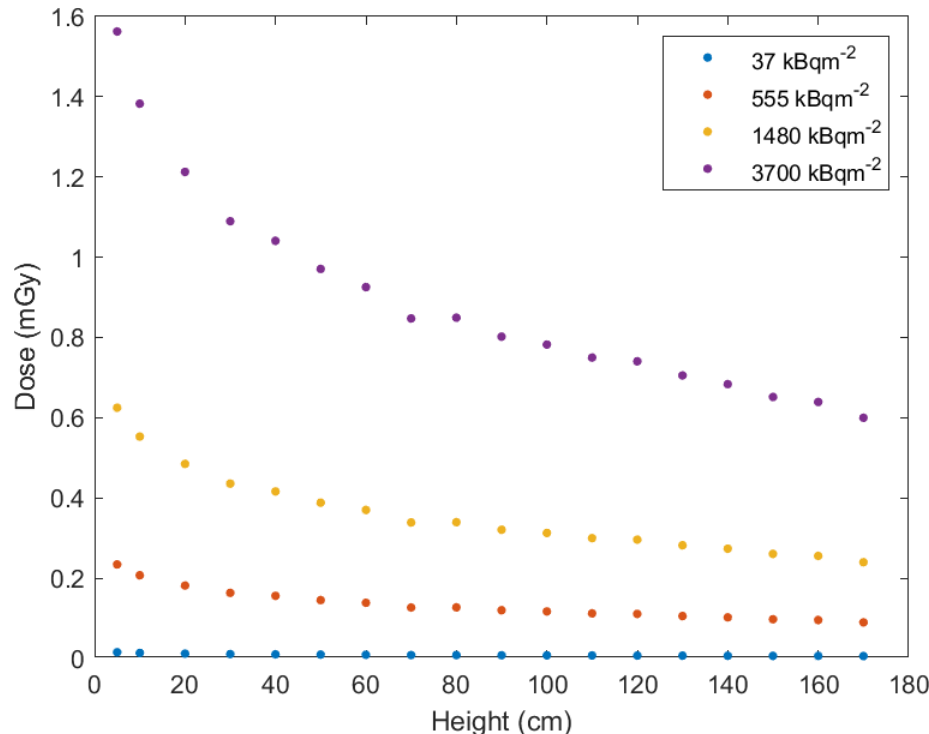
Figure 2. Absorbed dose to the cell (target) as a function of height (on the water phantom used in our simulations) induced by different 137 Cs surface activities for the exposure time of one week, using MCNP6.1 code.